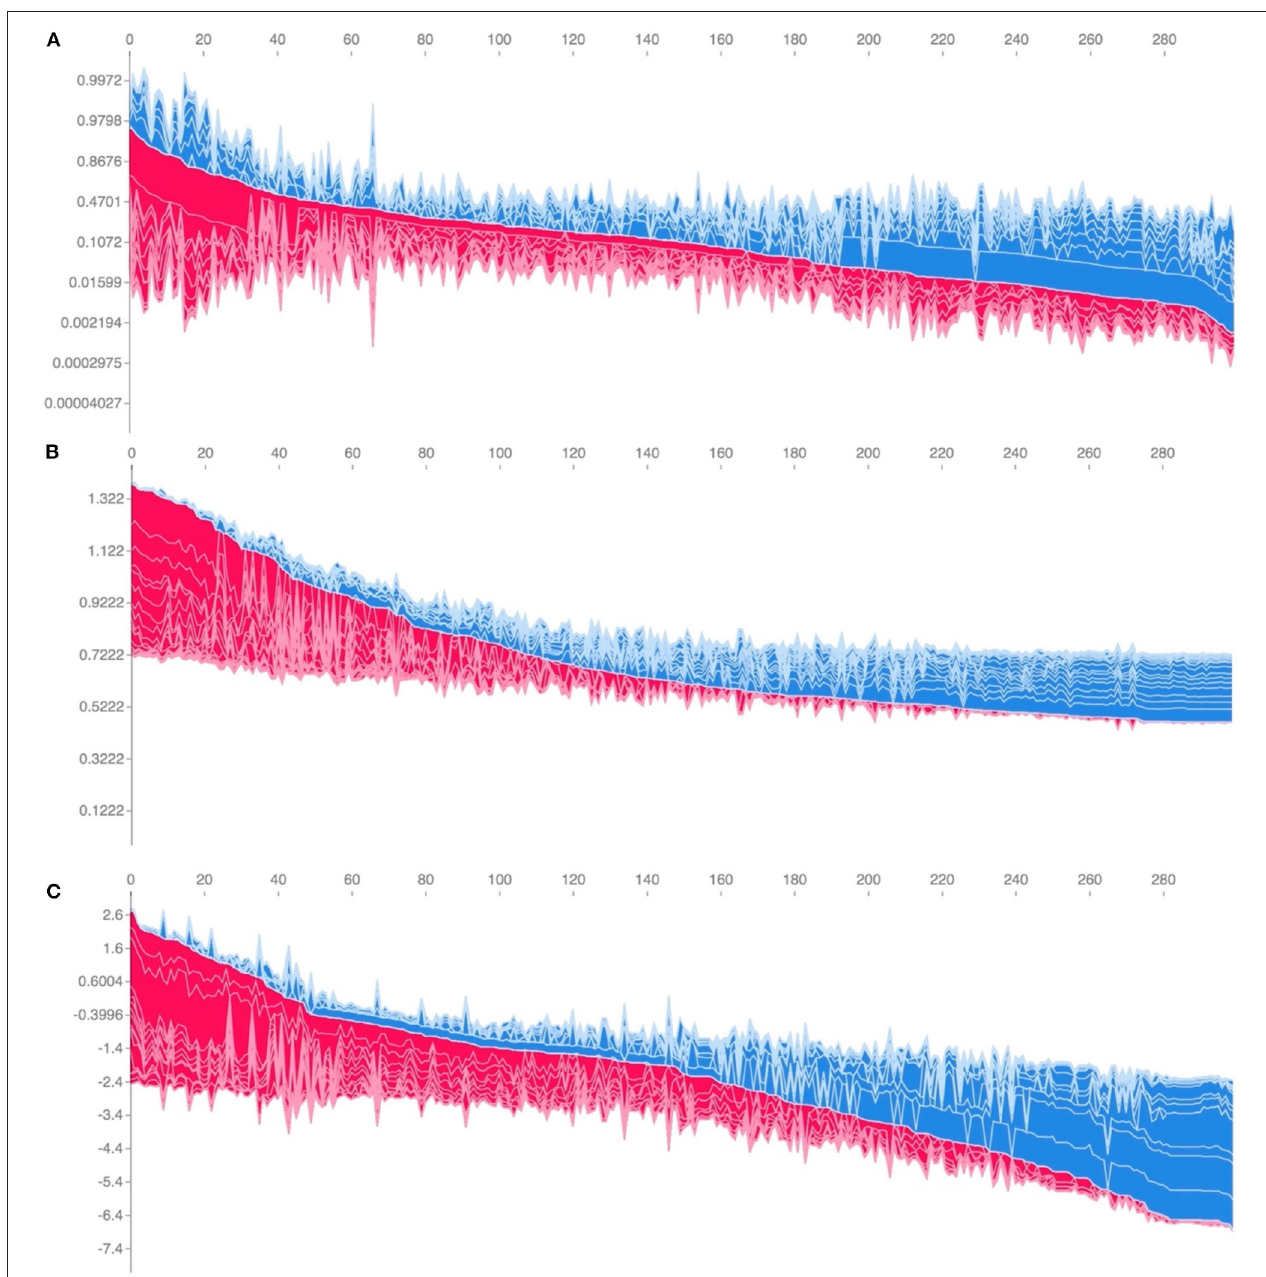
FIGURE 5 | Individual-patient explanations (force-plots) are rotated to a vertical position and stacked horizontally to form interactive plots detailing explanations of HAPI predictions across a large patient population while still allowing interrogation of each patient. We note here that this feature is a web-based interactive plot; the physician or end-user can hover over individuals with their computer mouse, from which the application will display/highlight the important predictors for those individuals. SHAP derived force plots depicting individual predictions and explanations for the first 300 hospitalizations in the study population, ordered from highest HAPI predicted probability (red) to lowest (blue) for: (A) Logistic Regression, (B) Random Forest, and (C) XGBoost (on log-odds